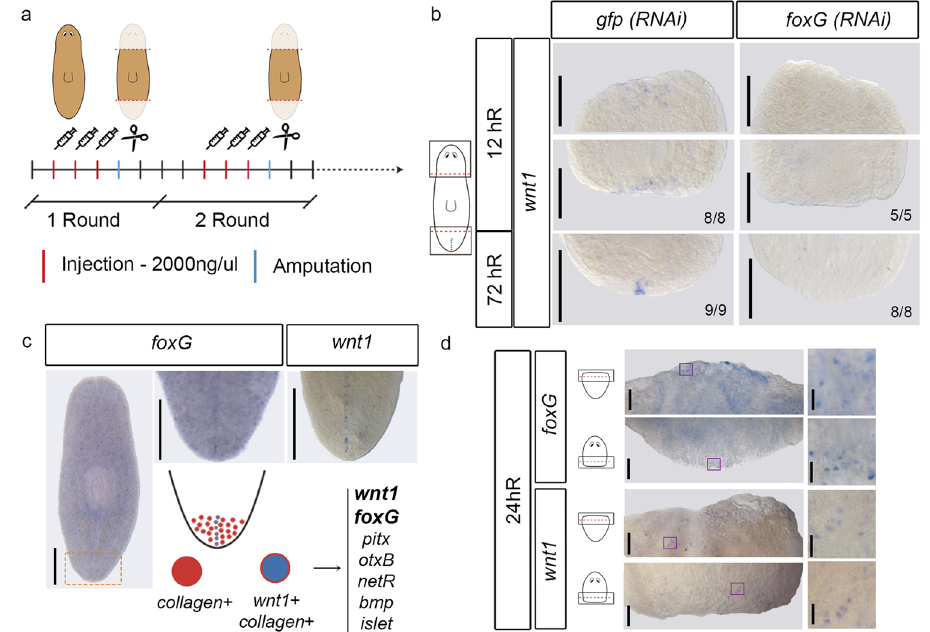
Fig. 4 | foxG is expressed in regenerating blastemas and regulates wnt1 expression.a Schematicillustrationindicatingthe foxG (RNAi)procedure. b WISH of wnt1 in foxG (RNAi) animals demonstrate its absence in both 12 and 72 hR wounds. Schematic illustration of wnt1 in intact animals with the analyzed zones (squares) added. Data representative of two independent experiments. c WISH of foxG inintact animalsshows itsexpression in the posteriormidline, similarto wnt1 expression. Data representative of one experiment. Orange dashed lines show the magni fi edarea.Singlecellanalysisperformedby 63 showedsixgenes(top16%)over